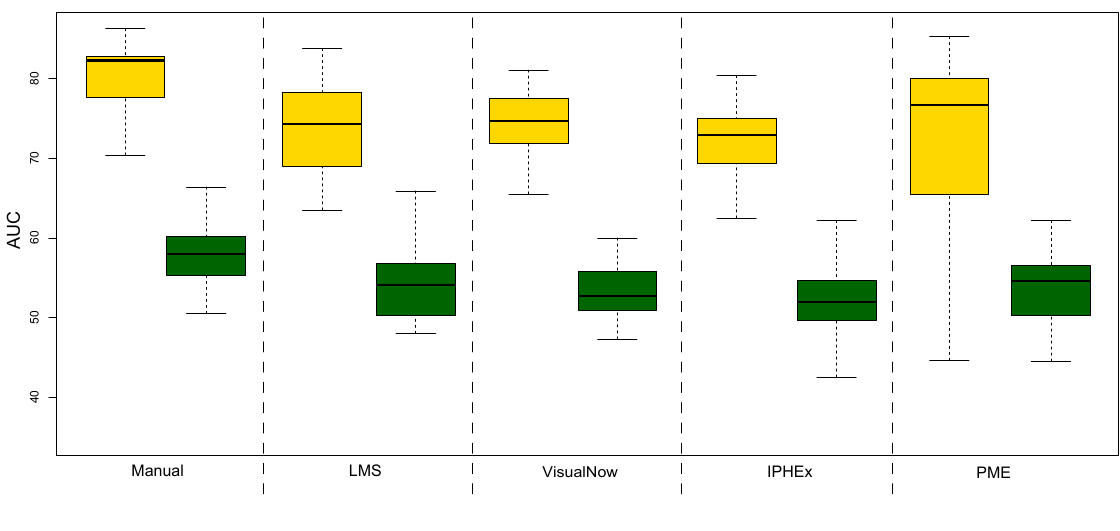
Figure A1. Boxplots illustrating the variation within the random forest tuning results in a single ten-fold cross validation run. The yellow boxes show the results when tuning the original feature sets. The green boxes show the results when tuning the randomly labeled feature